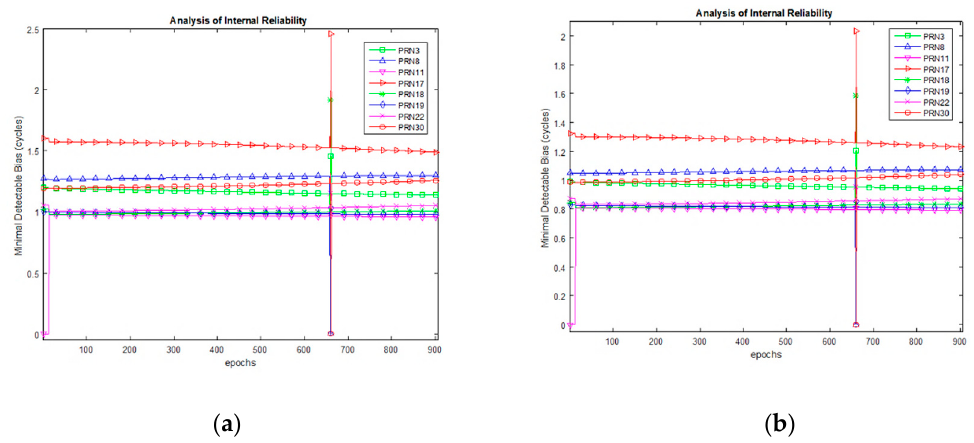
Figure 9. MDB for Dataset 2 for varying values of α 0 ( a ) α 0 = 0.1%, ( b ) α 0 = 1%.